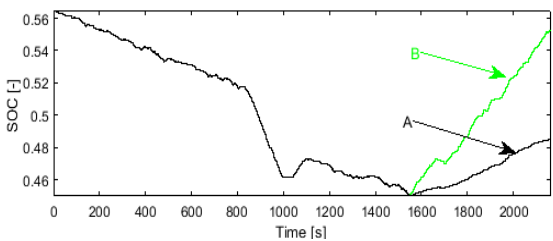
Figure 14. Battery SOC A) Without generator, B) With